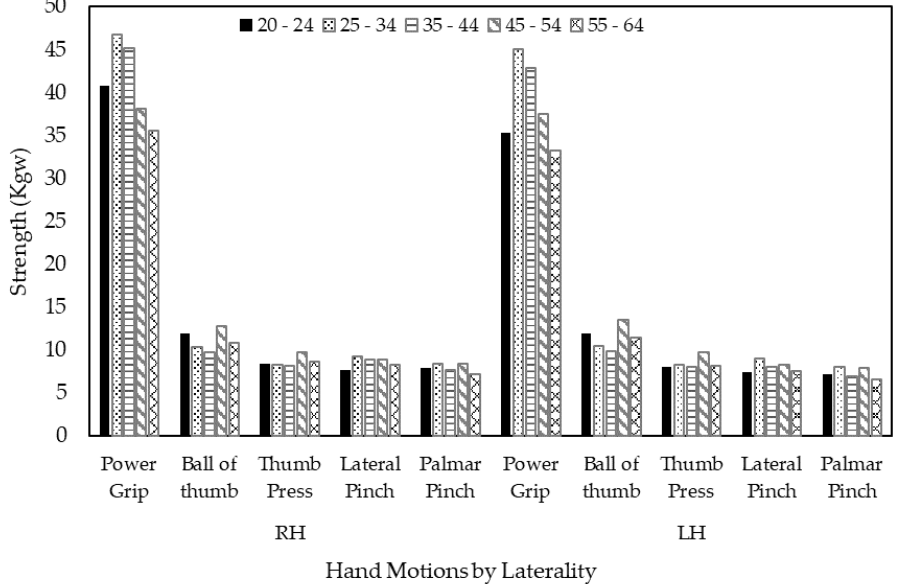
Figure 4. Age effects on hand strength by type of hand motion and laterality for male volunteers.